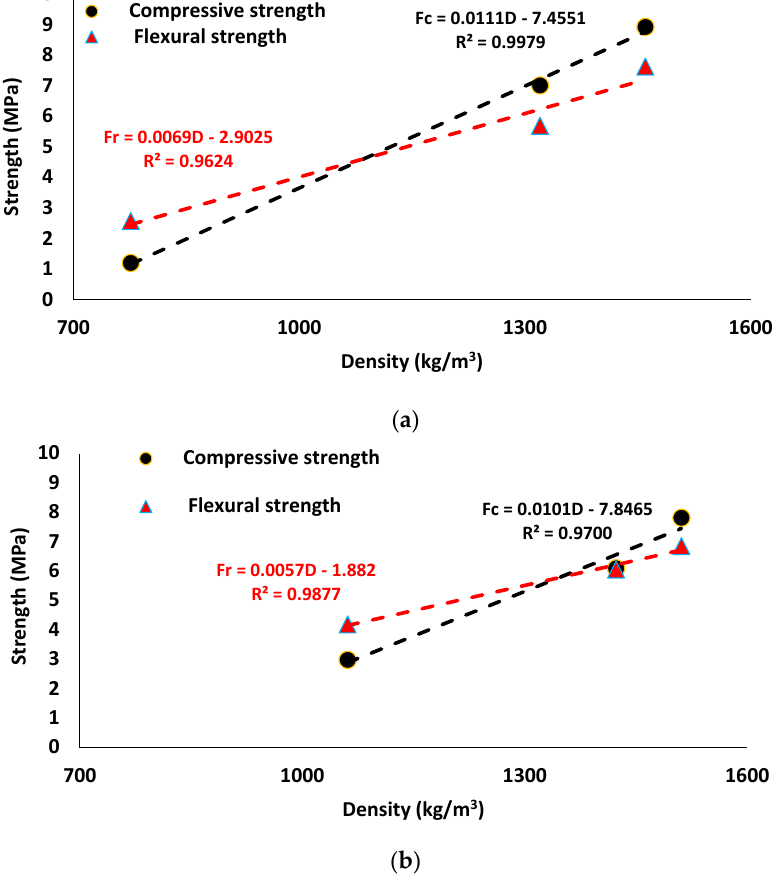
Figure 8. Correlation between the compressive and flexural strengths and density of lightweight mix compositions: ( a ) SW50/GW10; ( b ) SW30/GW30.